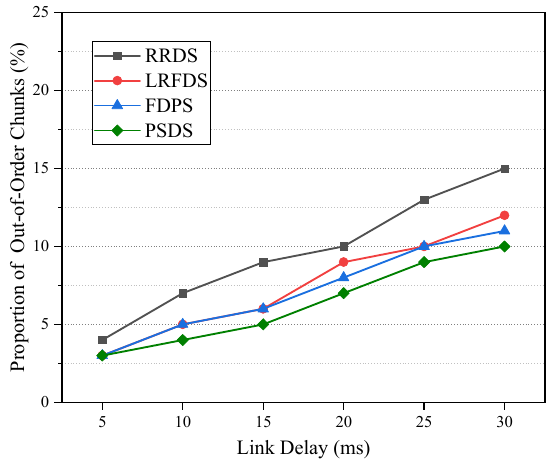
Figure 6. Proportion of out-of-order chunks under di ff erent link delays.